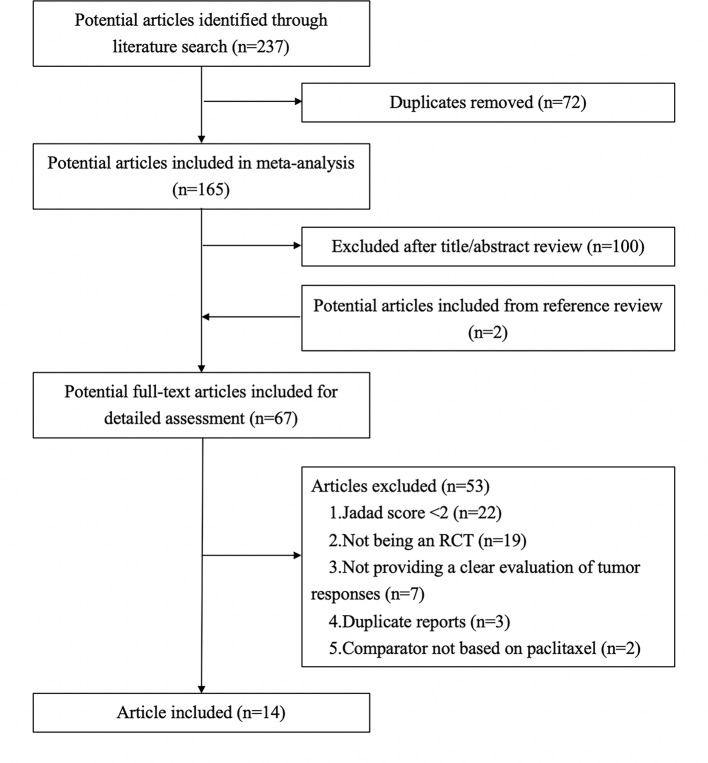
Flow diagram showing study selection for meta-analysis.